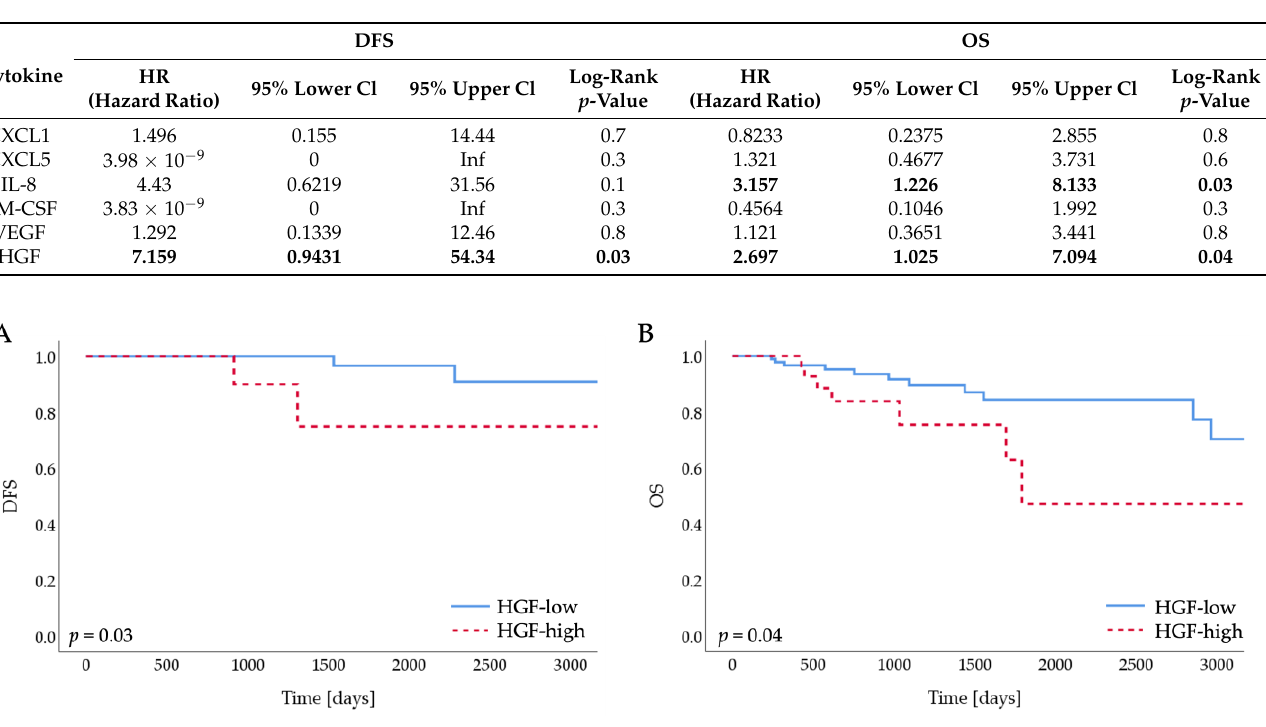
Figure 5. Kaplan–Meier survival curves of ( A ) disease-free survival (DFS) and ( B ) overall survival (OS) according to HGF expression in TCGA database.